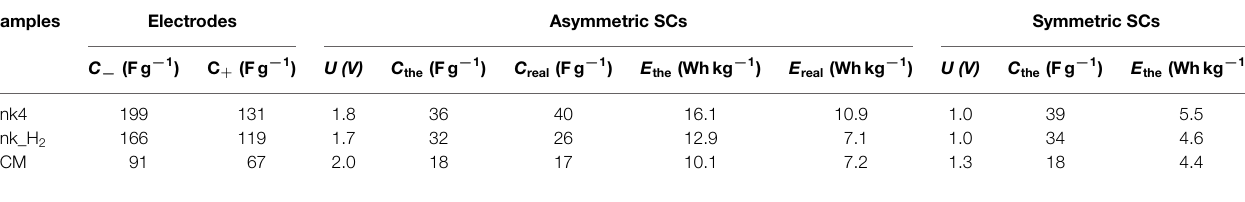
TABLE 4 | Specifications for the electrodes, asymmetric, and symmetric (theoretical values) supercapacitors .